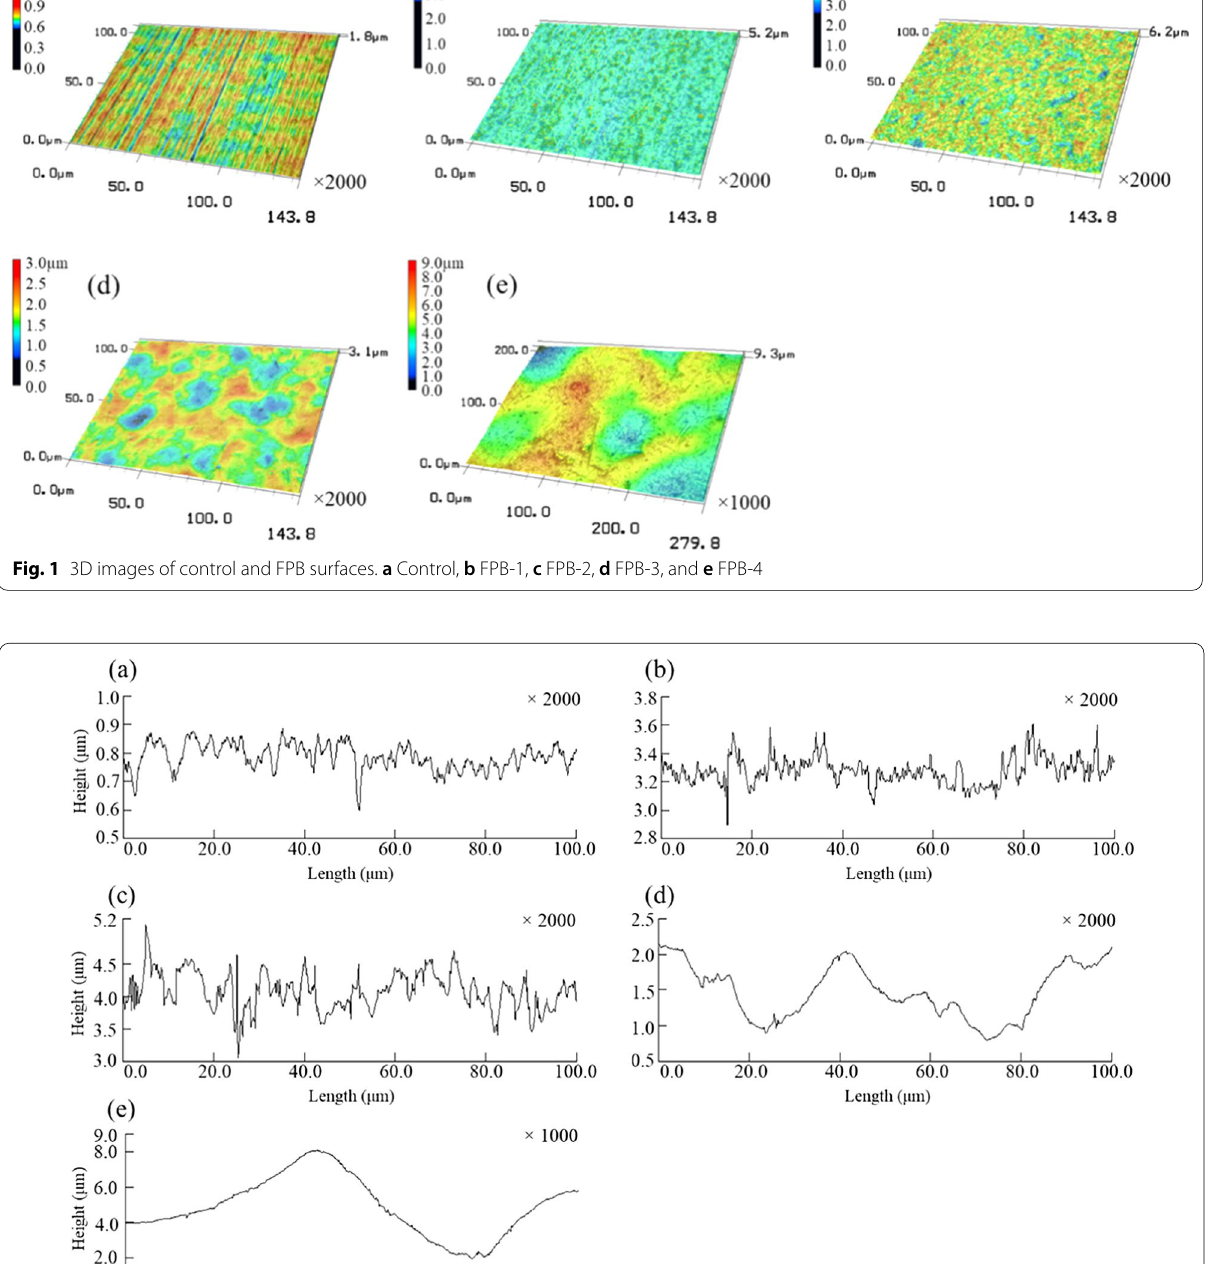
set (excitation filter: 570/40 nm, dichroic mirror: 600 nm,